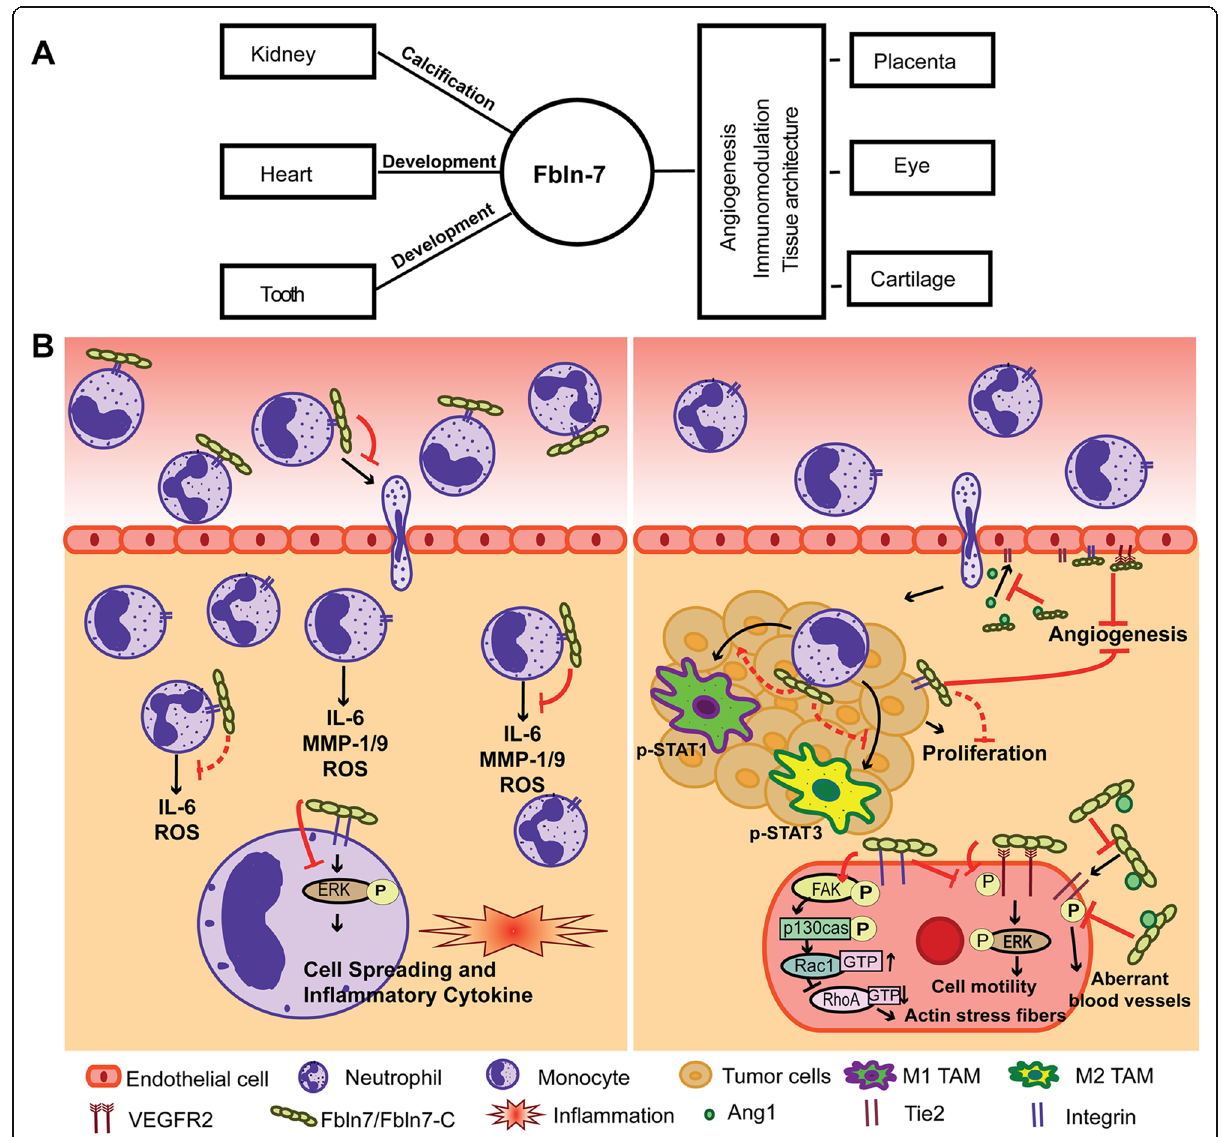
Fig. 2 Role of Fbln7 and its C-terminal fragment in the modulation of cellular functions under physiological and pathological conditions. a Under physiological conditions, the Fbln7 protein plays an essential role in the modulation of blood vessel formation, development, cell adhesion in multiple tissues such as placenta, eye, and cartilages. b One of the C-terminal fragment of Fbln7, Fbln7-C binds to immune cells such as monocytes/macrophages and neutrophils via integrin β 1 and regulate their migration and functions via binding to surface integrins and modulation of ERK1/2 and MAPK signaling pathway. Similarly, in tumor microenvironment interaction of cell surface integrin expressed on cancer cells, endothelium or TAMs inhibits the angiogenesis and progression of cancers via modulation of STAT and ERK pathways. Binding to VEGFR2 sustained activation of Rac1, and inhibition of VEGFR2 and ERK1/2 are possible mechanisms involved in the suppression of angiogenesis. Additionally, overexpression of Fbln7 also results in its binding to Ang1, thereby inhibiting the phosphorylation of Tie2 expressed in the endothelial